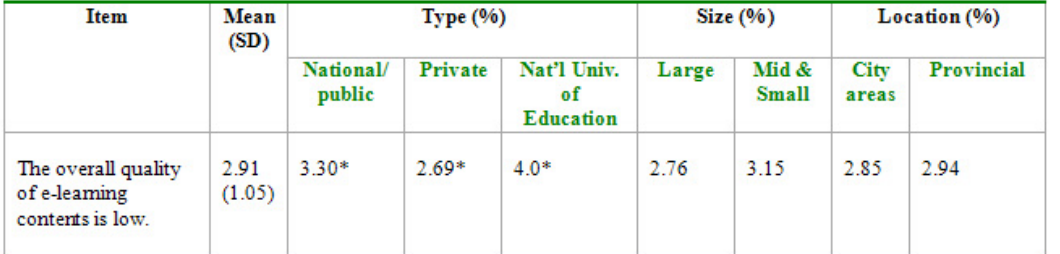
Table 8. Awareness on the Quality of e-Learning Contents